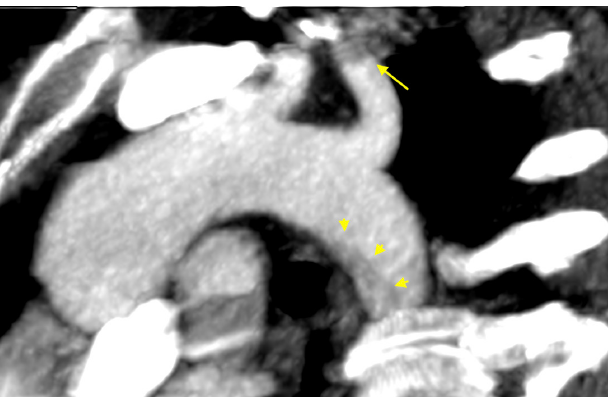
Fig. 1B - Volume-rendered two-dimensional imaging showing the left subclavian artery occlusion (yellow arrow) and the primary thoracic aortic mural thrombus (yellow arrowheads).